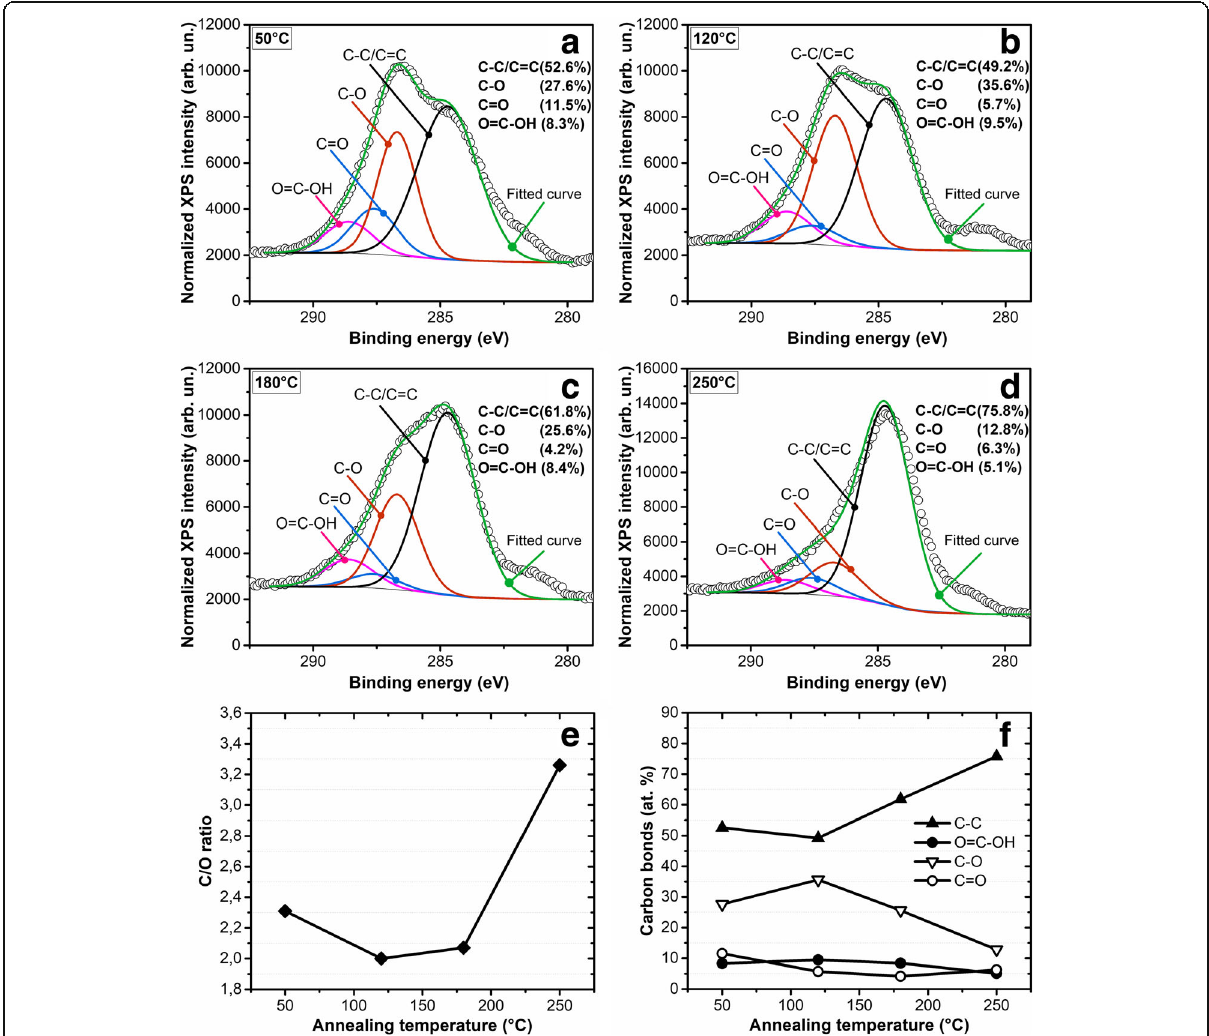
temperatures 50, 120, 180, and 250 °C ( a – d ). The different components related to various chemical shifts of carbon bonds are indicated. The relation of areas of the C1s to O1s XPS peaks ( e ) and the atomic percentages of different carbon bonds identified by XPS as a function